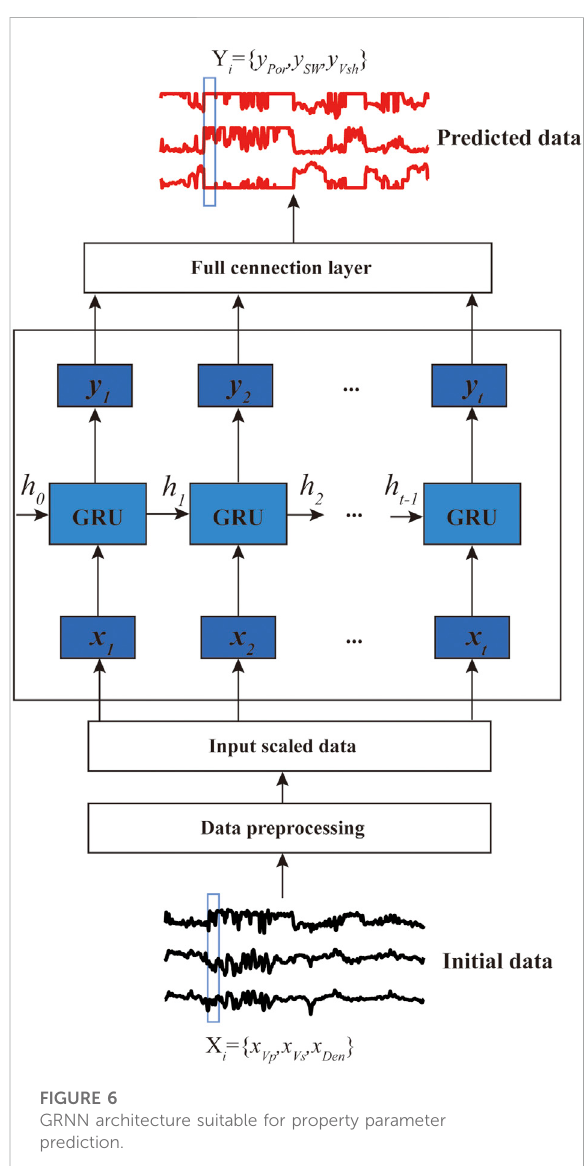
FIGURE 6 GRNN architecture suitable for property parameter